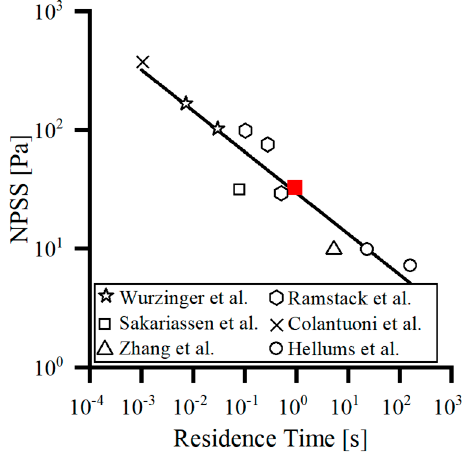
Figure 2. The threshold curve for platelet activation induced by NPSS-RT was fitted by Fraser et al. [42] based on previous studies [43–47].